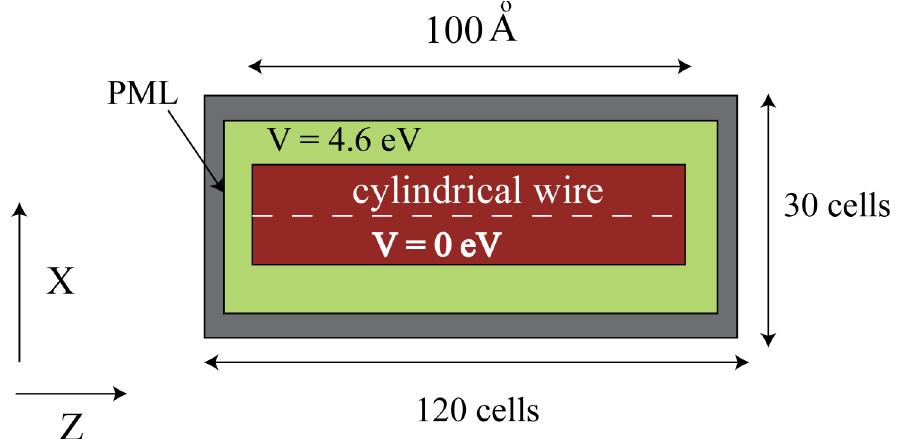
Fig 2. The problem space for the simulation of a cylindrical quantum wire. The cells are one Angstrom cubed. The entire three-dimensional space is 30x30x120 cells. (The Y direction is not